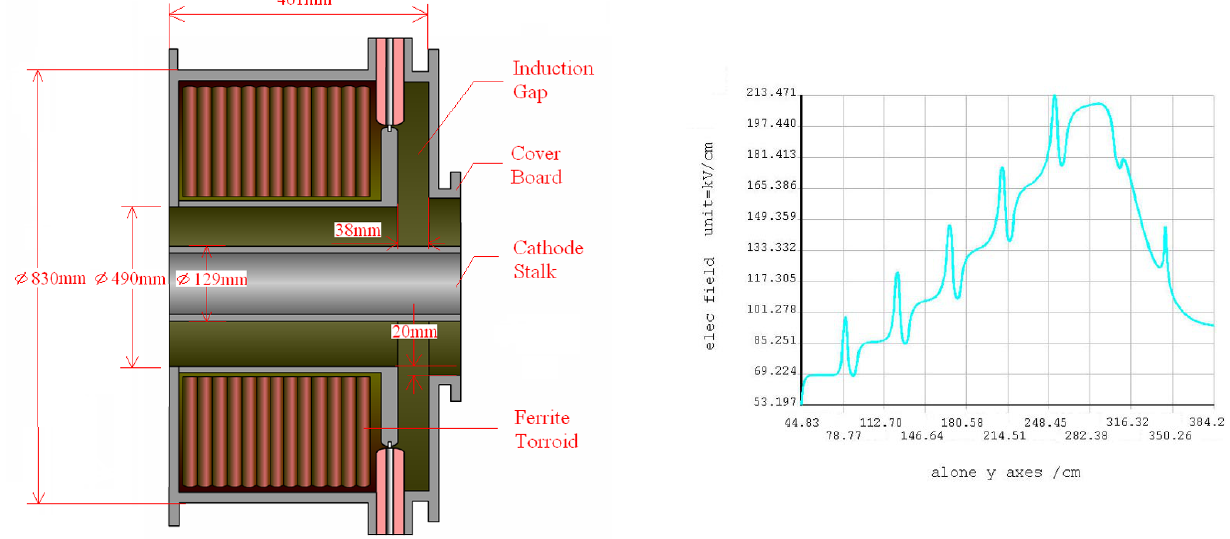
FIG. 7. (Color) Cut-away view of the cell adjacent to cathode (left) and field distribution along cathode stalk